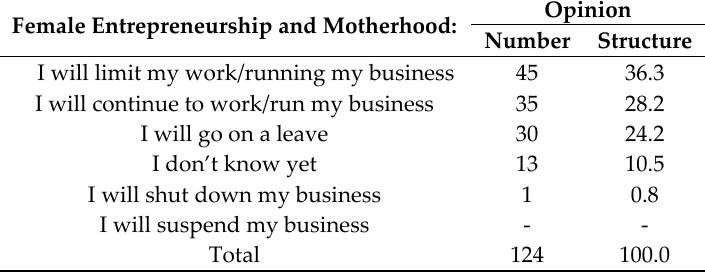
Table 1. Entrepreneurial activity and motherhood in the opinion of women. Female Entrepreneurship and